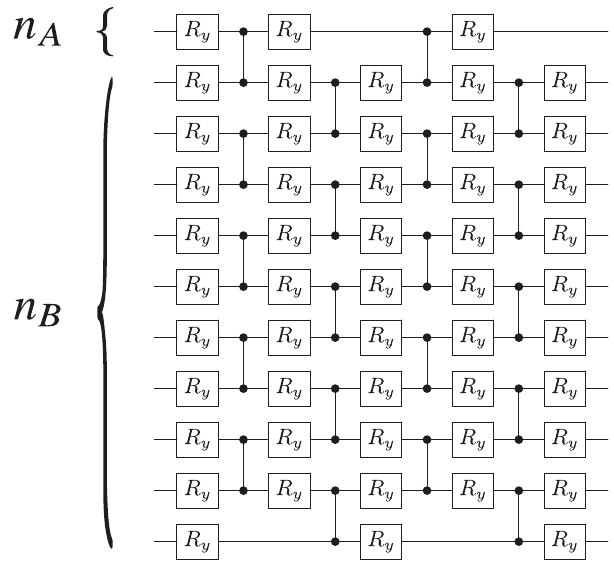
Fig. 4 Alternating Layered Ansatz for V ( θ ) employed in our numerical simulations. Each layer is composed of control- Z gates acting on alternating pairs of neighboring qubits which are preceded and followed by single qubit rotations around the y -axis, R y ð θ i Þ ¼ e (cid:2) i θ i σ y = 2 . Shown is the case of two layers, n A = 1, and n B = 10 qubits. The number of variational parameters and gates scales linearly with n B : for the case shown there are 71 gates and 51 parameters. While each block in this ansatz will not form an exact local 2-design, and hence does not fall under our theorems, one can still obtain a cost-function-dependent barren